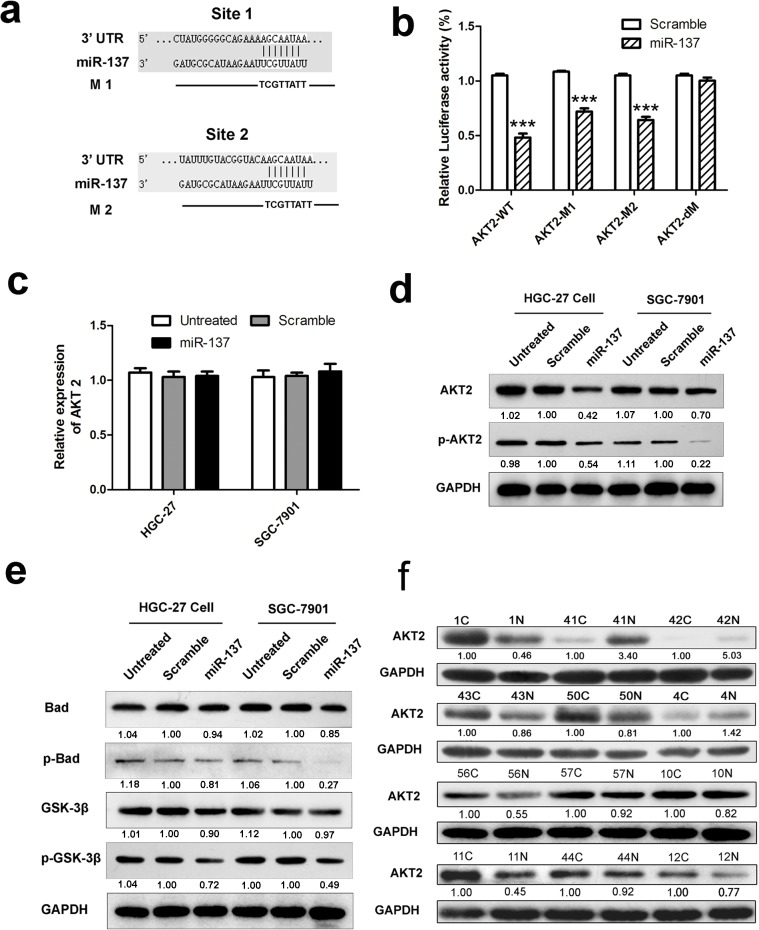
AKT2 is experimentally validated as a direct target of miR-137.
A. Sequence of the miR-137 binding sites within the human AKT2 3’-UTR and a schematic diagram of the reporter constructs showing the entire AKT2 3’-UTR sequence (AKT2_WT) and the mutated AKT2 3’-UTR sequence (M1, M2). B. Luciferase activity of the AKT2_WT reporter and the AKT2_MUT reporter in the presence of 10 nmol/L of miR-137 mimic or scramble. C. Relative expression of AKT2 in HGC-27 and SGC-7901 cells not transfected or transfected with miR-137 mimics or scramble 24 hours. D. Immunoblotting of AKT2 in HGC-27 and SGC-7901 cells not transfected or transfected with miR-137 mimic or scramble. All data are shown as mean ± SD. E. Immunoblotting of Bad, GSK-3β, p-Bad and p-GSK-β.fWestern blot analysis of AKT2 protein level in 12 GC patients in whom miR-137 was down regulatedin their GC tissues.